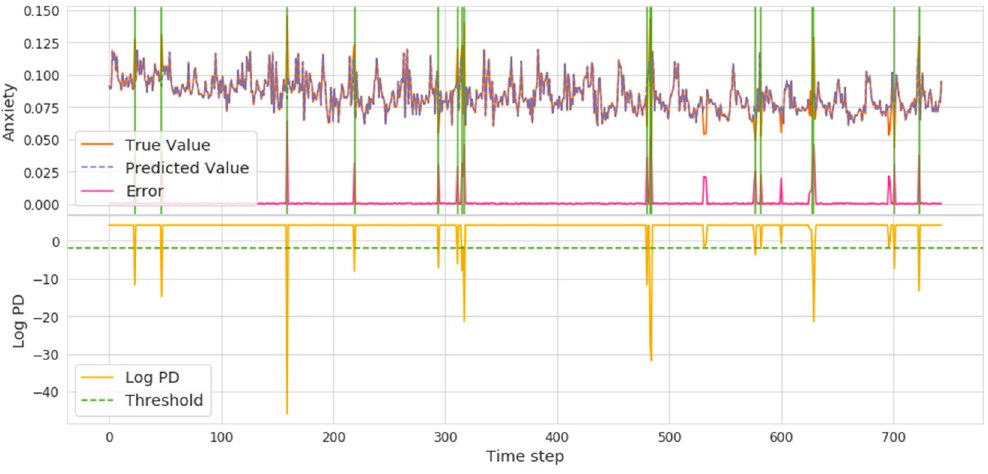
Figure 8. Anxiety Volatility and Abrupt Time Points.